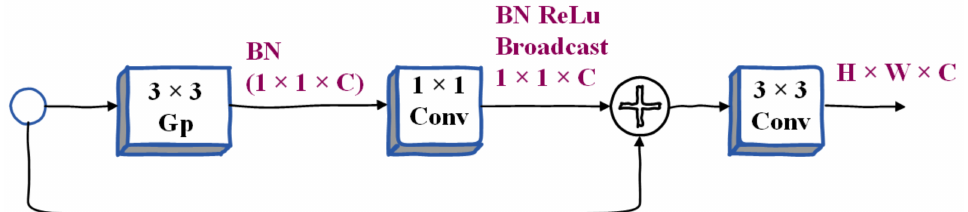
Figure 4. Illustration of Context Embedding